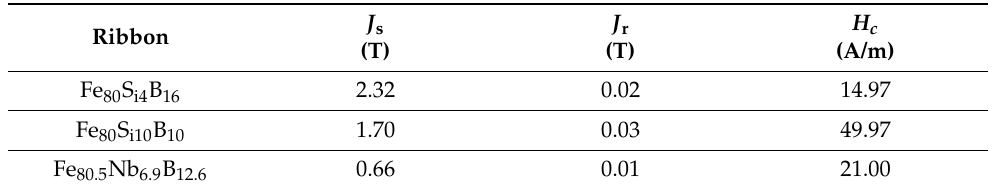
Table 1. Bulk magnetic parameters of investigated ribbons: J s —saturation magnetic